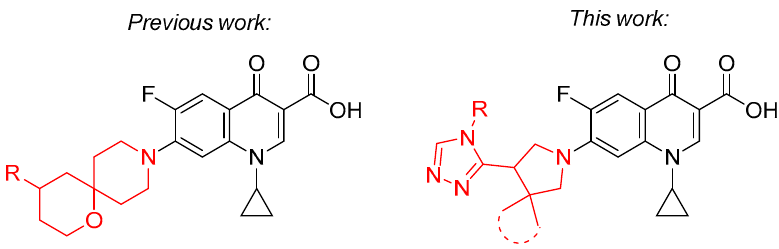
Figure 2. Spirocyclic congeners of ciprofloxacin reported previously and explored in this work.